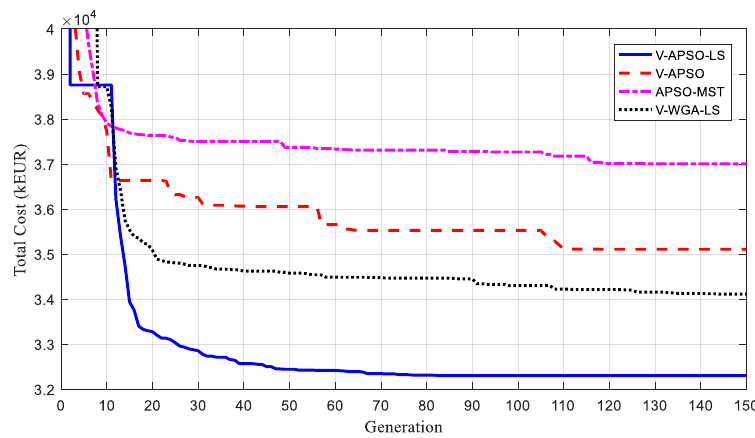
Figure 14. Total cost corresponding to each generation. Table 2. The best, mean and worst solutions obtained by different algorithms in 10 trials.